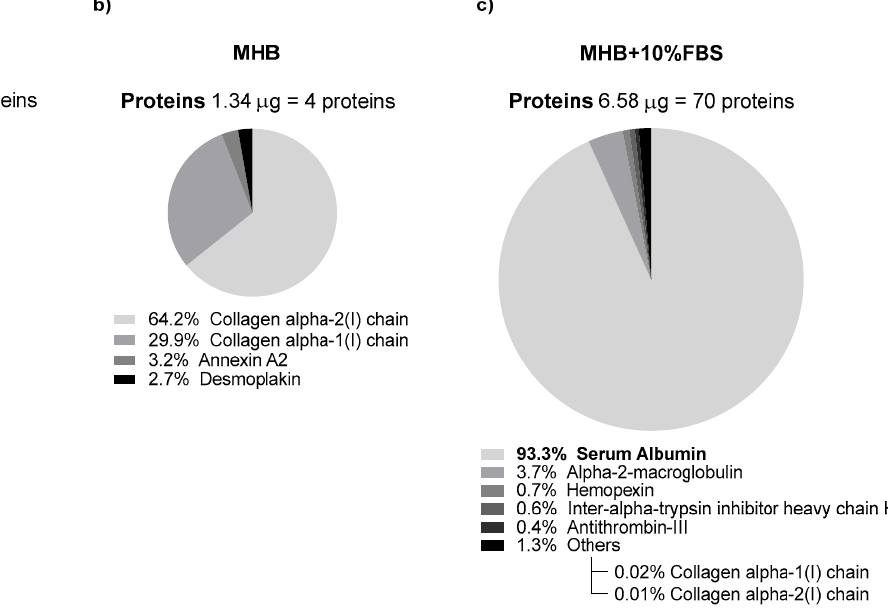
Figure 9. Schematic representation of the adsorbed proteins to NLC60 M surface. Protein corona composition in NLC incubated in: ( a ) PBS, ( b ) MHB and ( c ) MHB + 10% FBS. Most abundant proteins represented in respective percentages of total protein adsorption. A total of 500 ng of each sample were analyzed.